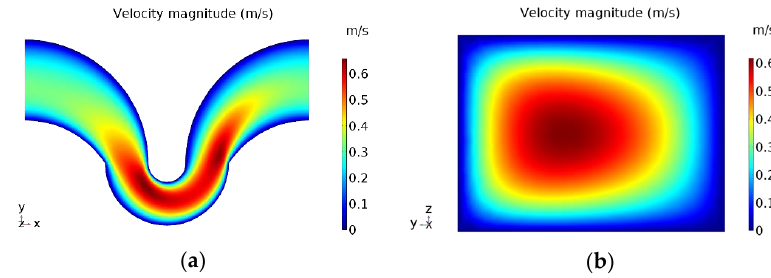
Figure 6. ( a ) Flow velocity magnitude for Q = 130 μL/min and h = 73 μm measured at z = 36.5 μm, at the middle height of the fluidic channel; ( b ) Flow velocity magnitude for the same flow conditions measured at the y - z plane halfway through the small curve.